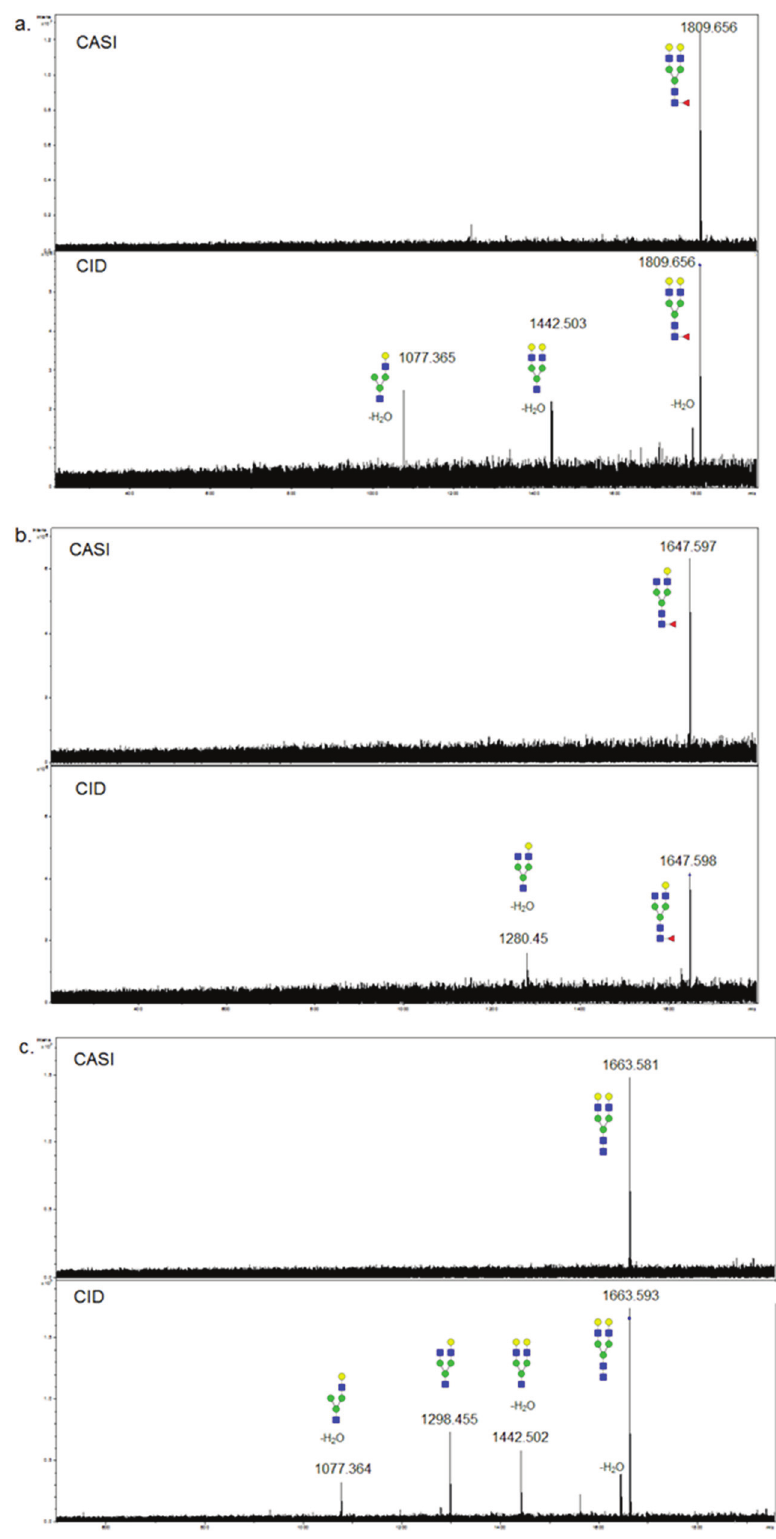
Figure 6. Collision-Induced Disocciation of Singly Fucosylated Tissue N -glycans. N -glycans were fragmented by CASI-CID directly from tissue sections as previously described [20,21]. The top panel for each glycan is the spectra following CASI capture, and the bottom panels show the fragmentation ions after CID; ( a ) Hex5dHex1HexNAc4 ( m / z = 1809.656); ( b ) Hex4dHex1HexNAc4 ( m / z = 1647.598); ( c ) Hex5HexNAc4 ( m / z =